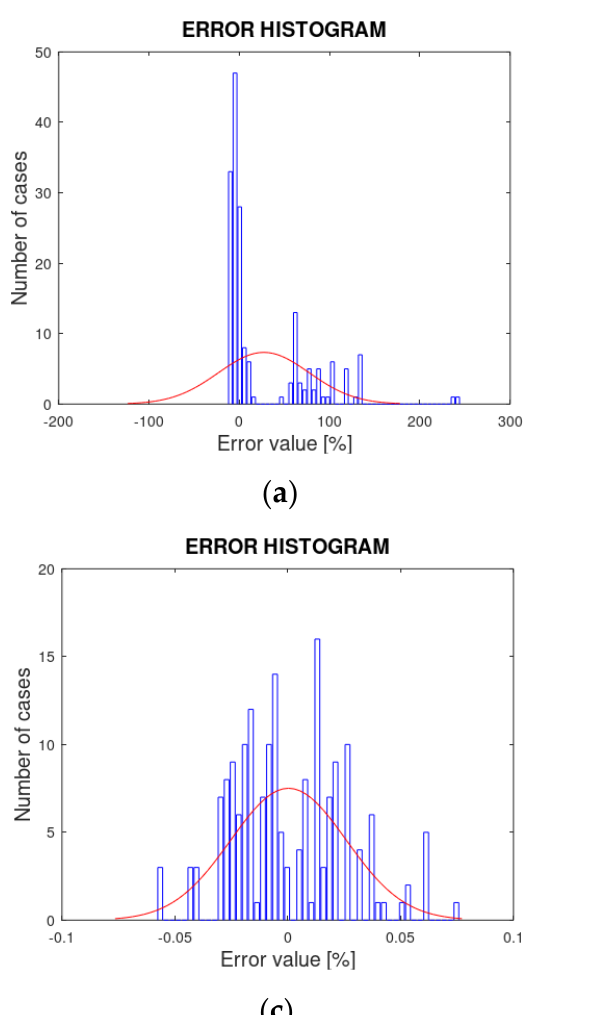
17 of 26 The comparisons made are shown in Table 2. Table 2. Comparisons of developed numerical experiments. C1 [38] Table 4. Metrics of the proposed comparisons.